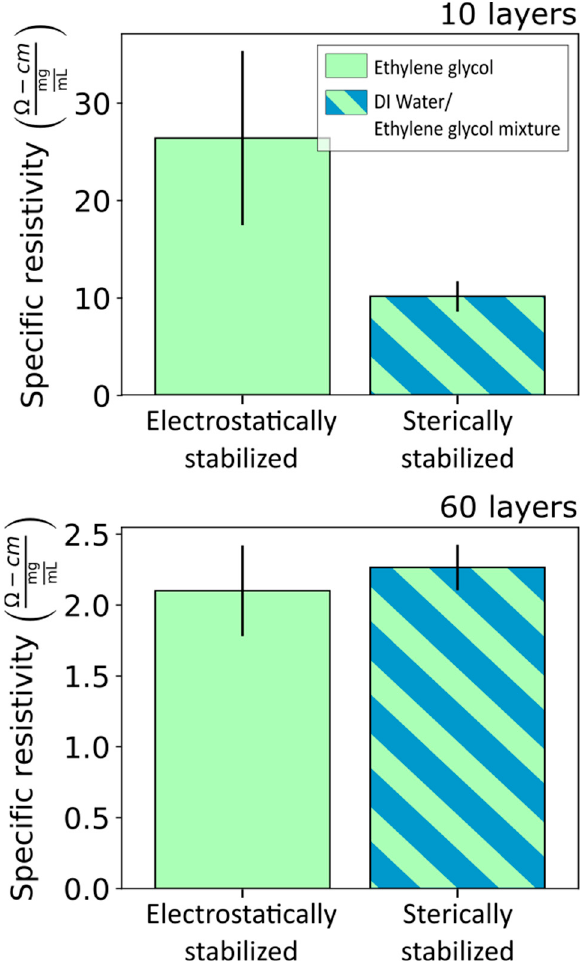
Figure 10. The resistivity of 10 (top) and 60 (bottom) printed layers of electrostatically and sterically stabilized MGNS inks normalized by their solid loading.